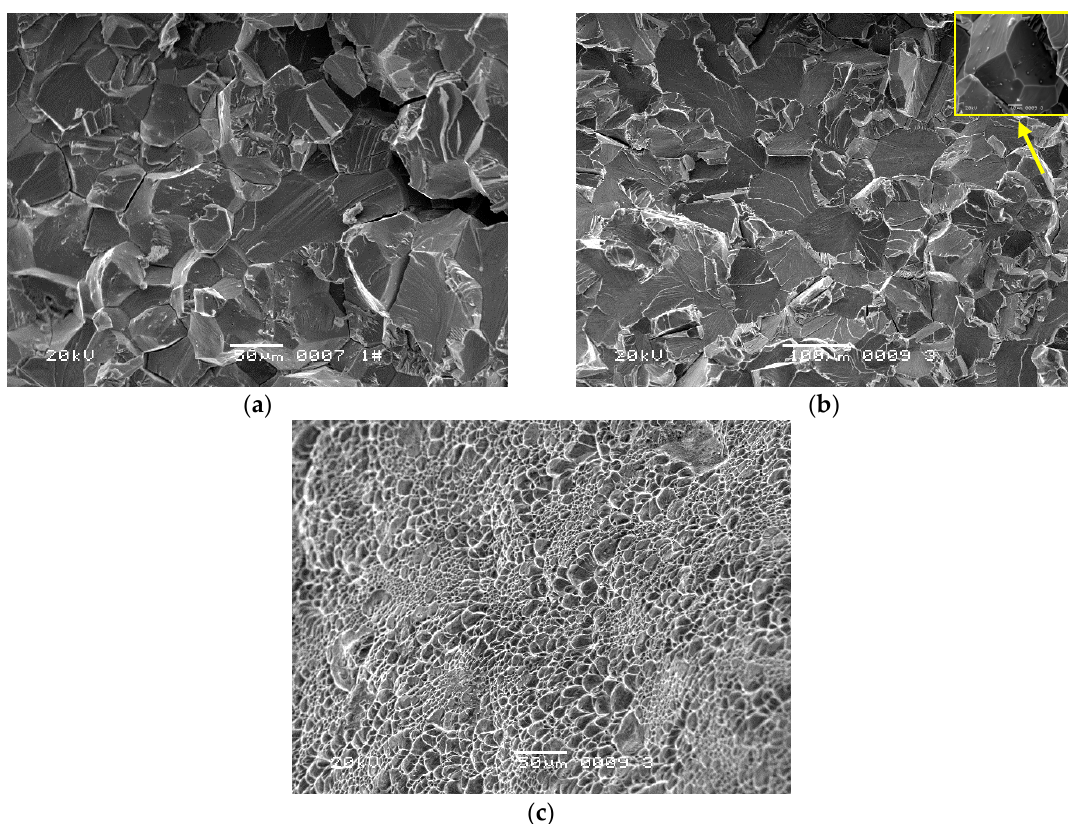
Figure 6. ( a ) Grain boundary cracking and cleavage morphology in Region I (50 μ m); ( b ) Cleavage morphology and Grain boundary cracking in Region II (yellow square, 10 μ m); ( c ) Dimple morphology in Region III (100 μ m).